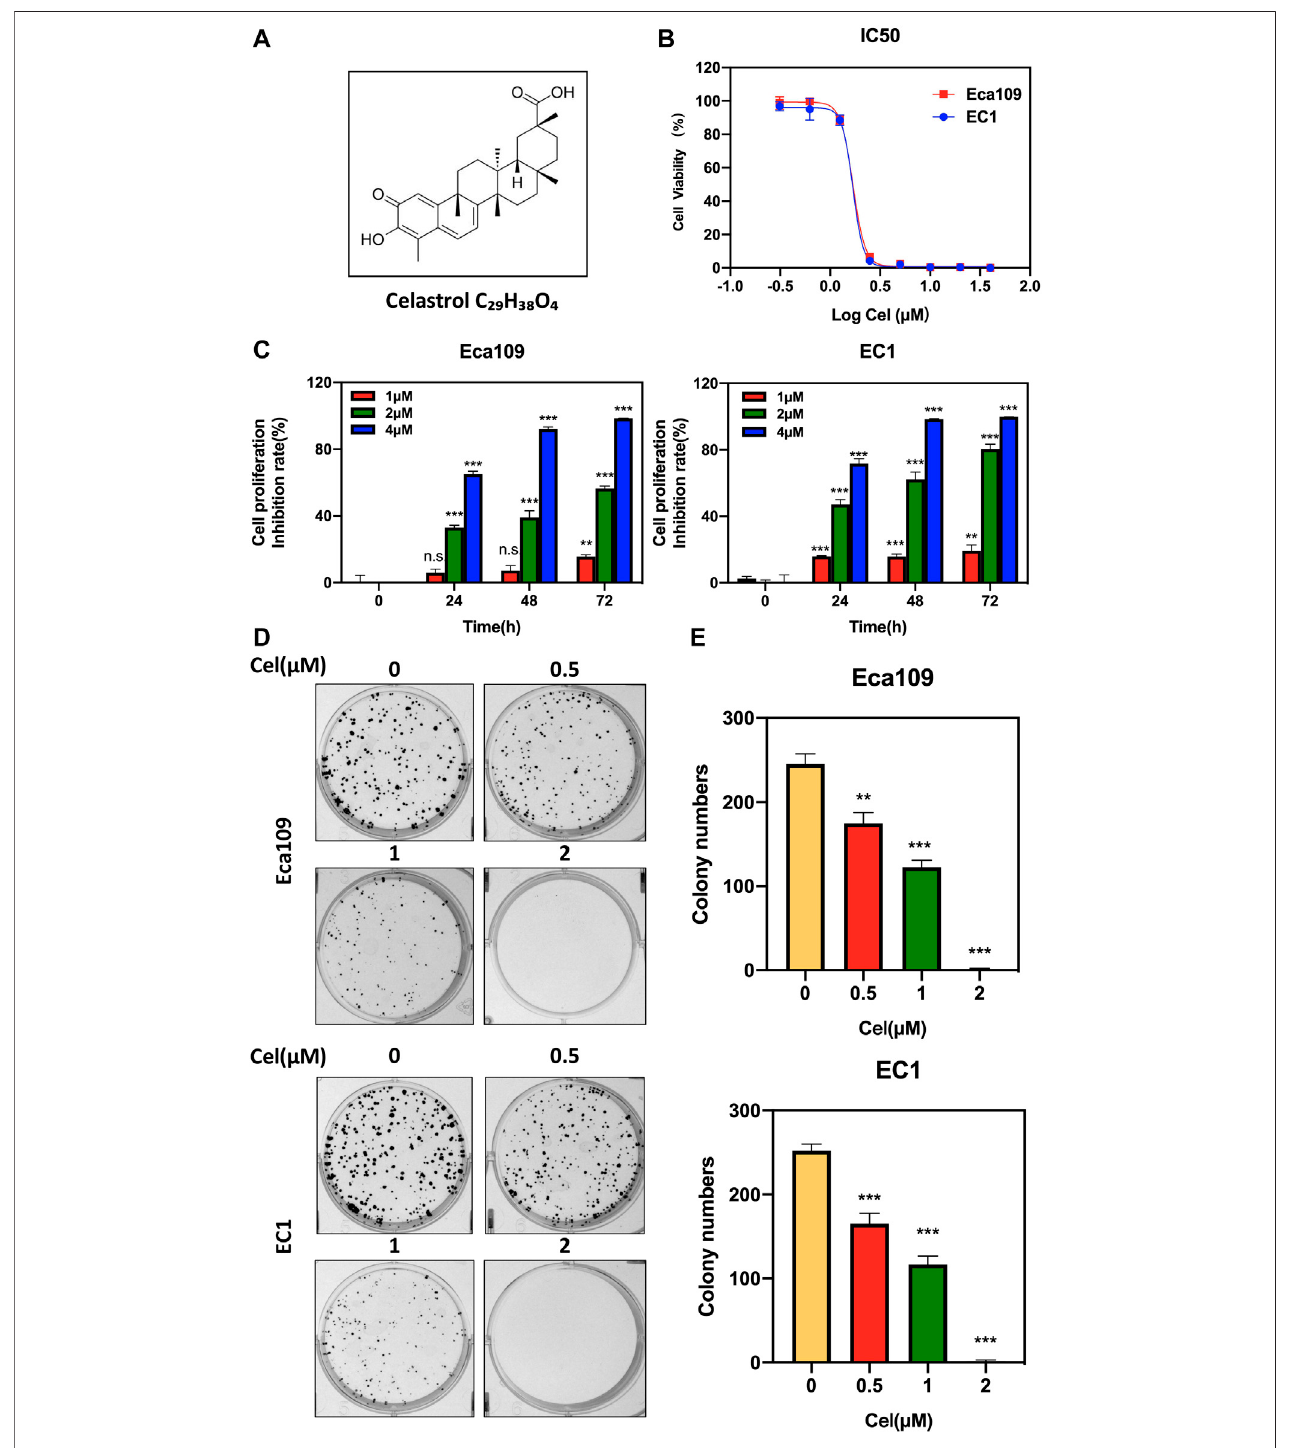
FIGURE 1 | Celastrol inhibited the viability of ESCC cells. (A) Chemical structure of celastrol. (B) Human ESCC cells Eca109 and EC1 were treated with indicated concentrations of celastrol for 72 h, and cell viability was determined by ATPlite assay. Representative inhibitory curves for each cell line were shown. (C) ATPlite assay wasused to determine thecell growth ofEca109 and EC1 cells at the indicated concentrationof celastrol or DMSO for 0, 24, 48, and 72 h (D,E) Representative images of three independent experiments were shown for the inhibition of colony formation by 0.5, 1, and 2 μ M celastrol or DMSO for 10 days. Graphs of the relative number of colonies were performed. pp denotes p < 0.01, ppp denotes p < 0.001, n.s. denotes not signi fi cant.